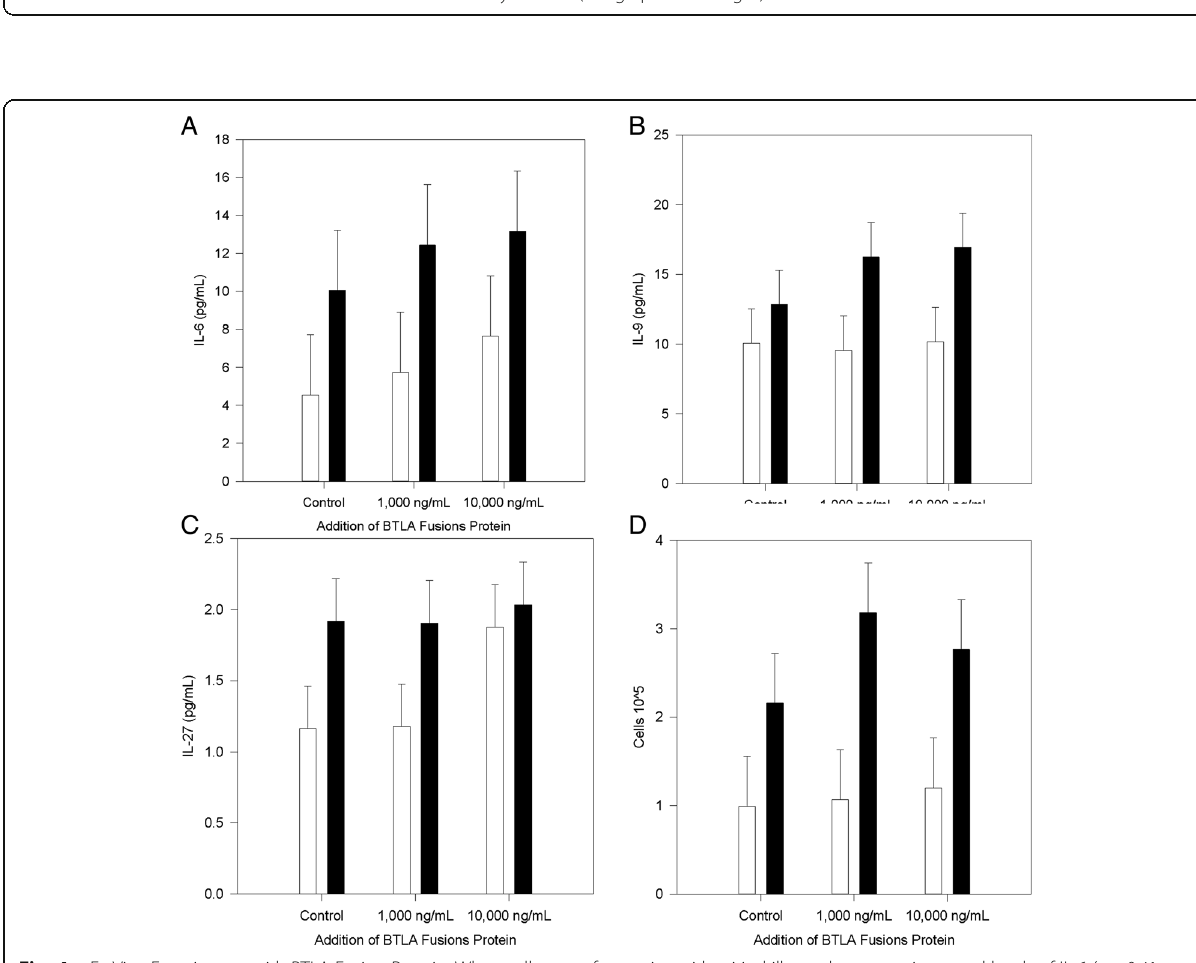
Fig. 4 – Ex Vivo Experiments with BTLA Fusion Protein: When cells came from mice with critical illness there were increased levels of IL-6 ( p =0.41, Figure a ), IL-9 ( p =0.019, Figure b ), IL-27 ( p =0.044, Figure c ) and cellular proliferation ( p =0.004, Figure d ). The addition of 1000 ng/mL of BTLA fusion protein also increased cellular proliferation ( p =0.021, Figure d